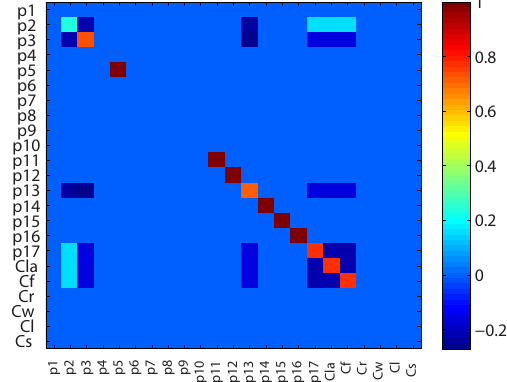
Figure 6. Model resolution matrix for the LAI operator.